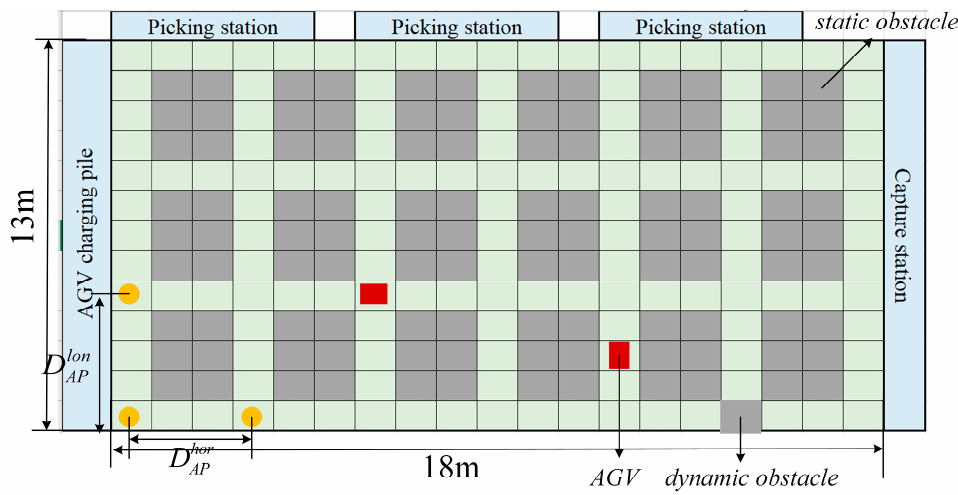
Figure 12. Simulation environment. Table 4. Simulation parameters related to VLC channel.